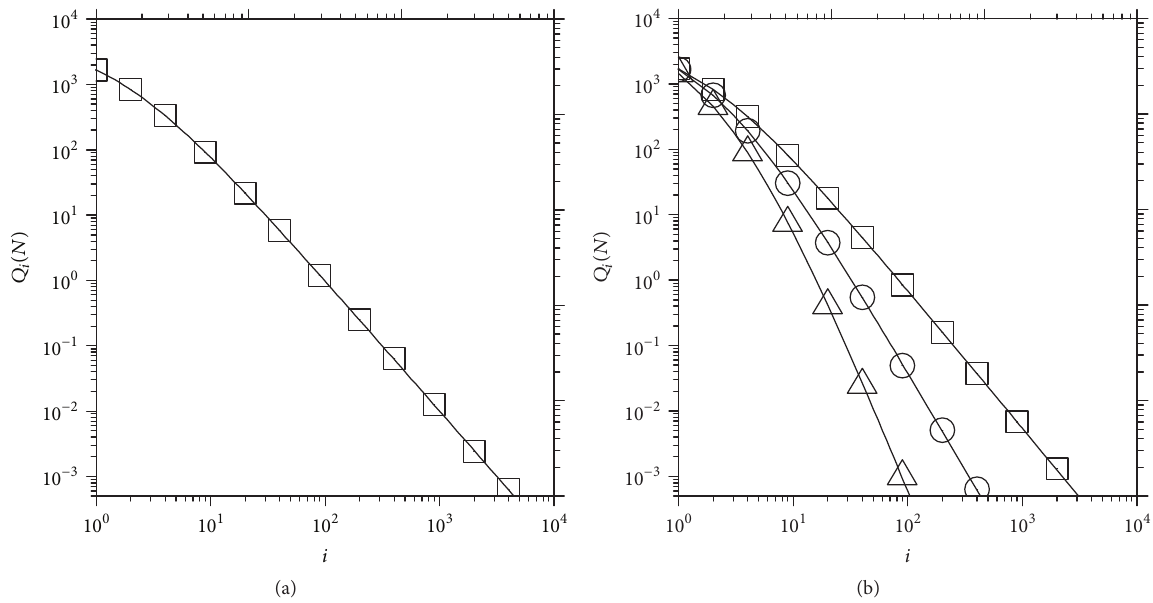
Figure 4: Comparison of the in-degree distributions obtained numerically (symbols ⊡ ⊙ Δ ) and the analytical results (solid lines) as a function of the in-degree 𝑖 . (a) Equation (18). (b) Equation (20) with 𝑝 = 0.1, 0.5 , and 0.7